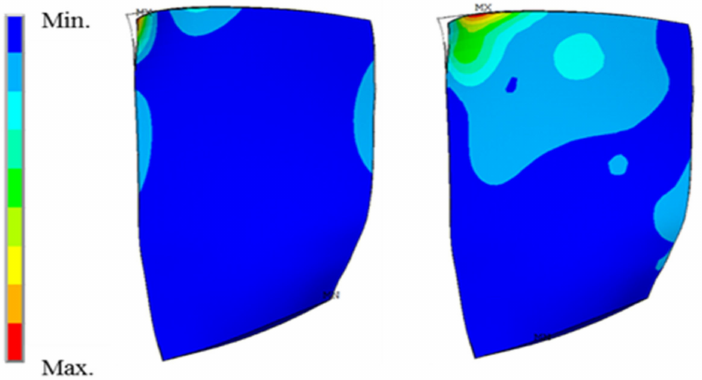
Figure 7. Rotor blade M8 mode shape (left: total displacement, right: von Mises stress).